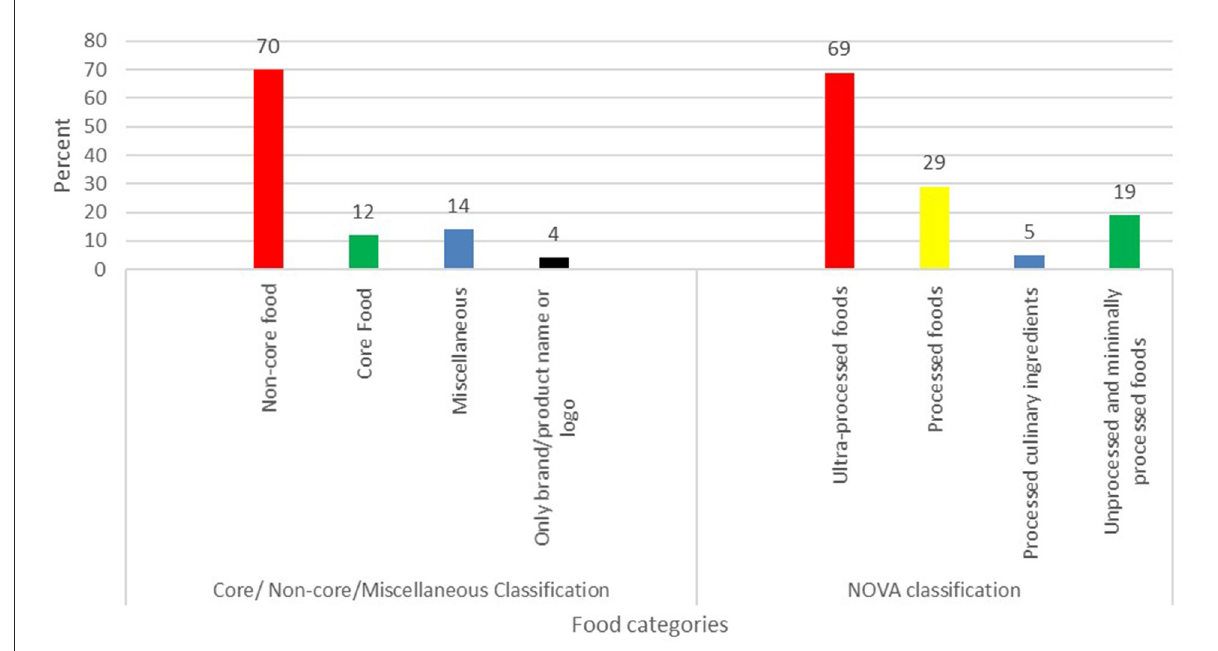
FIGURE3 The proportion (%) of promoted foods and beverages by food categories.